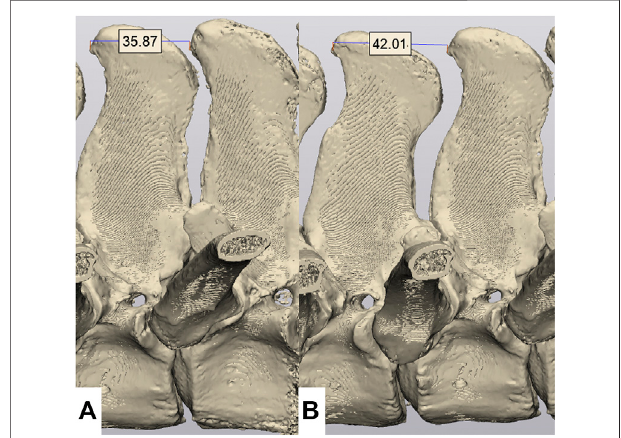
FIGURE 3 | Measurement of the inter DSP distance. Measurements are made from the cranial aspect of one DSP to the cranial aspect of the adjacent DSP. (A) Flexion phase, demonstrating an inter DSP distance of 35.87 mm. (B) Resting phase, demonstrating a inter DSP distance of 42.01